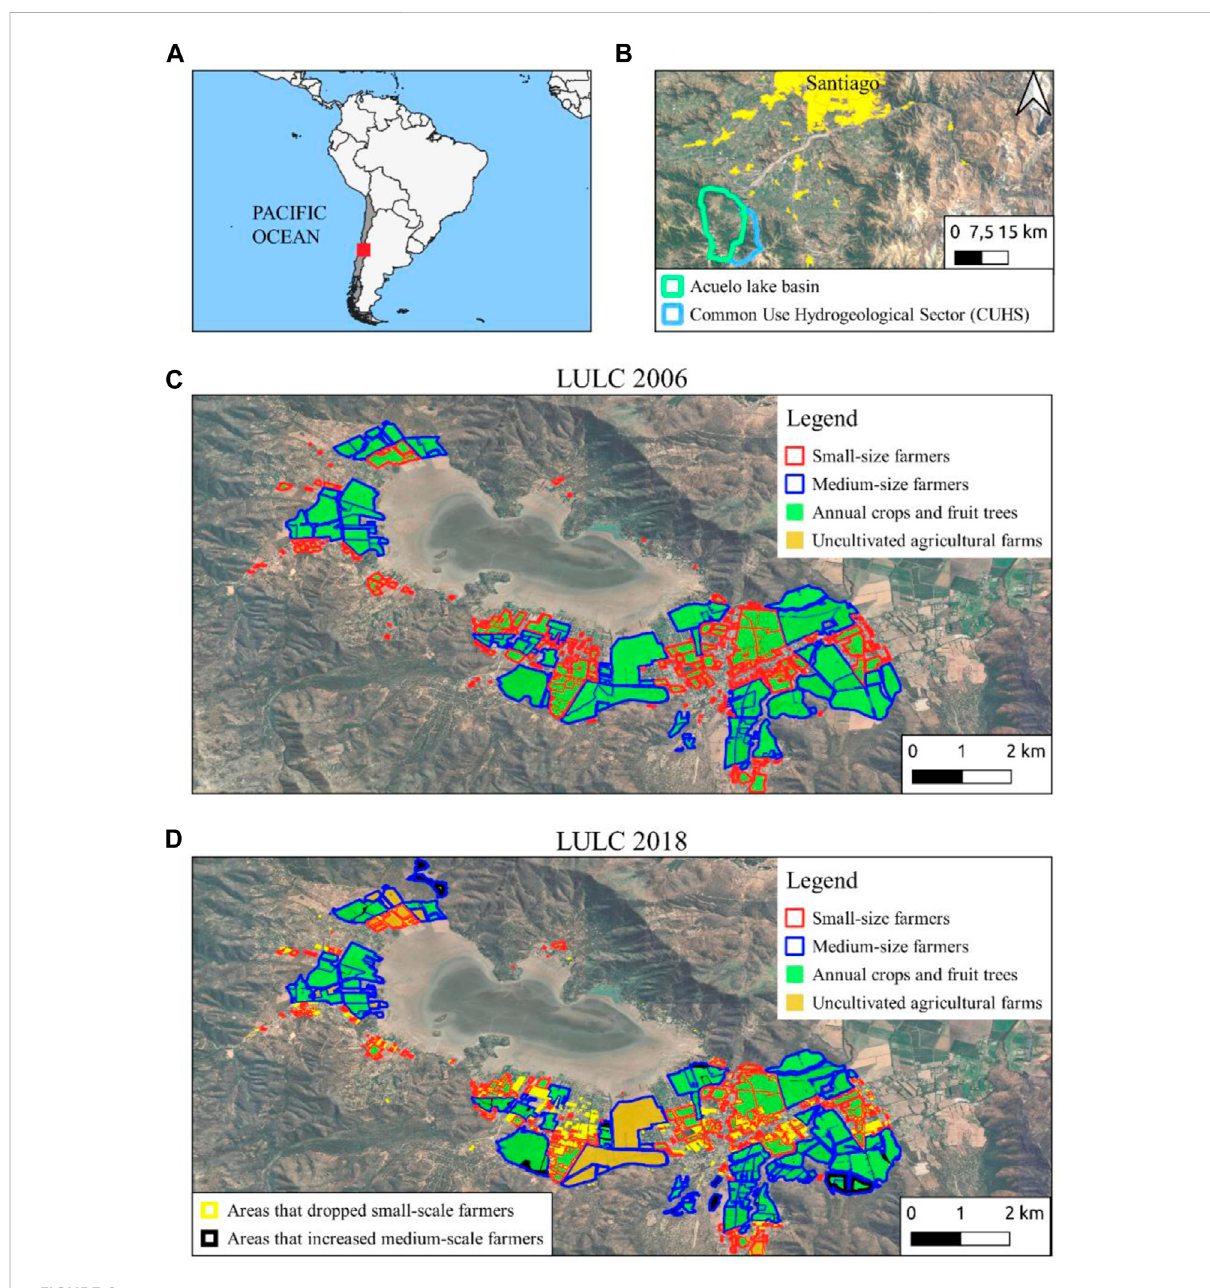
FIGURE 2 (A) Location of the study site in the Metropolitan Region, Central Chile, (B) location in respect with the Santiago de Chile city. (C) distribution of farm sizes in 2006 and (D) in 2018. The small-scale farmers are indicated using the red line, and the medium-scale farmers using the blue line. The productive farms are shown in green, and the uncultivated (grassland) farms are shown in